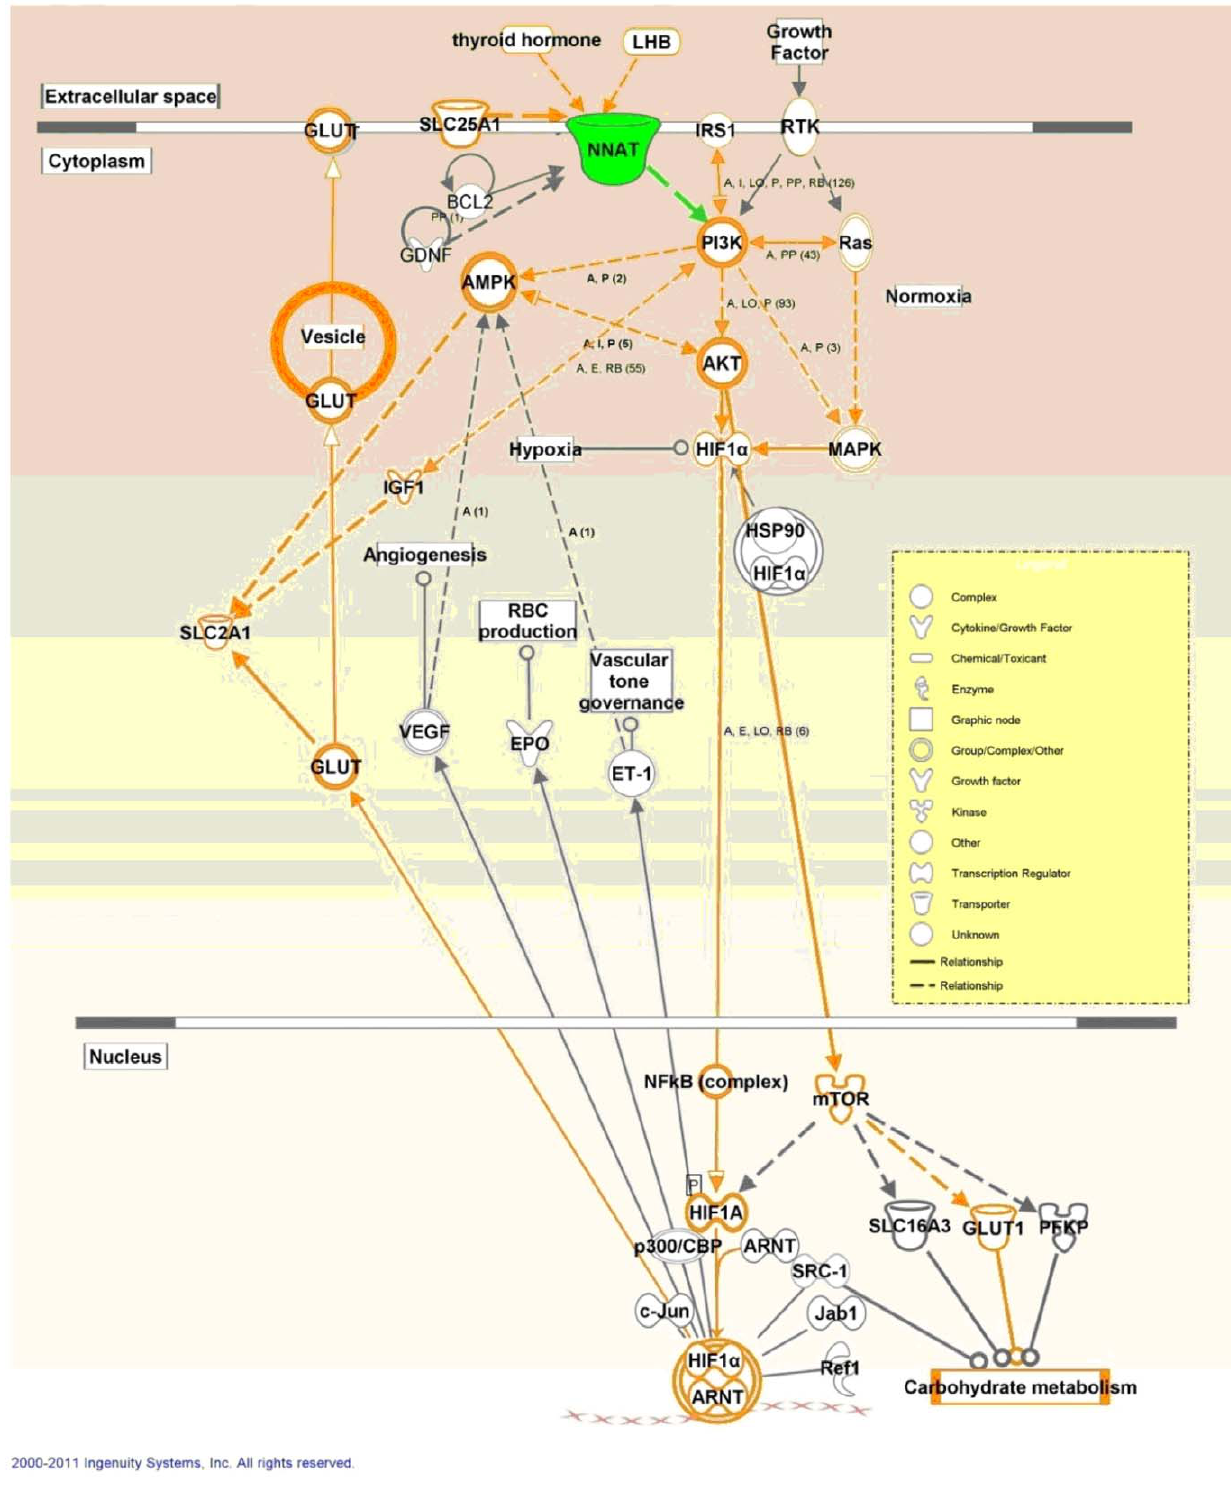
Figure 5. Gene-interaction network analysis of NNAT . Solid lines represented direct regulation and dashed lines represent deduced regulation.